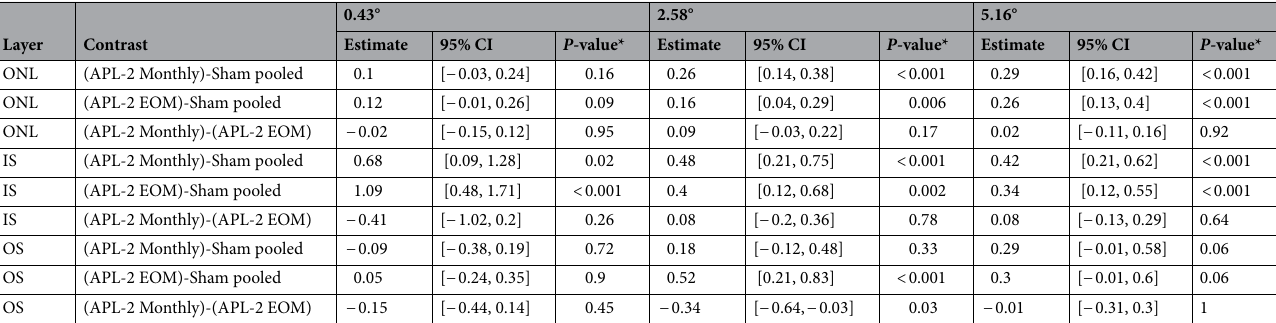
Table 2. Study eye differences in thickness at the level of photoreceptor layers (in z-score units) at three contour-lines at month 12 (modified intention-to-treat [mITT] analysis). * P -values were obtained using Kenward-Roger approximation to estimate the denominator degrees of freedom. P -values were adjusted within each model (i.e., combination of layer and contour-line) using the Tukey method for comparing a family of 3